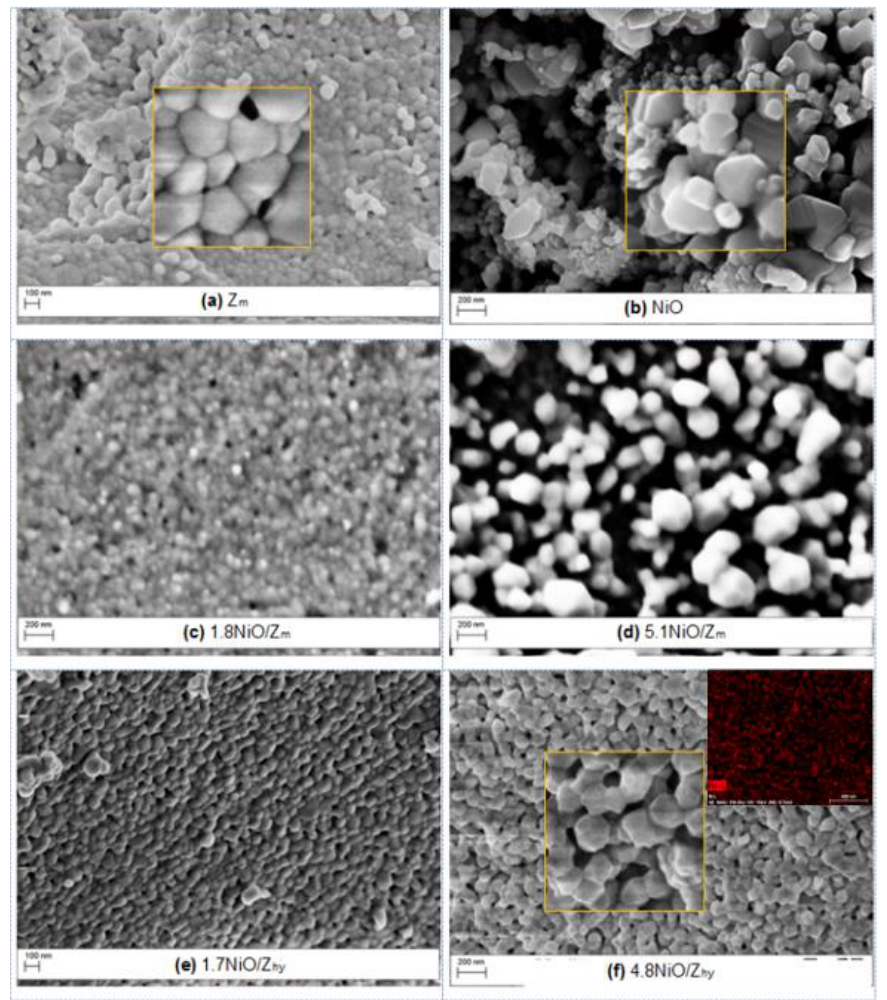
Figure 2. FESEM images of monoclinic ZrO 2 , unsupported NiO and NiO/ZrO 2 catalyst precursors. Magnifications of selected areas are shown in the insets of ( a ), ( b ) and ( f ). The inset with red dots in ( f ) refers to the Ni EDX elemental map.